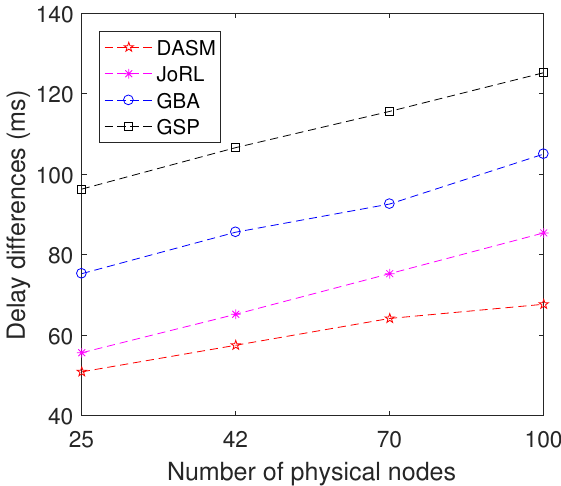
Figure 8. Delay difference of parallel